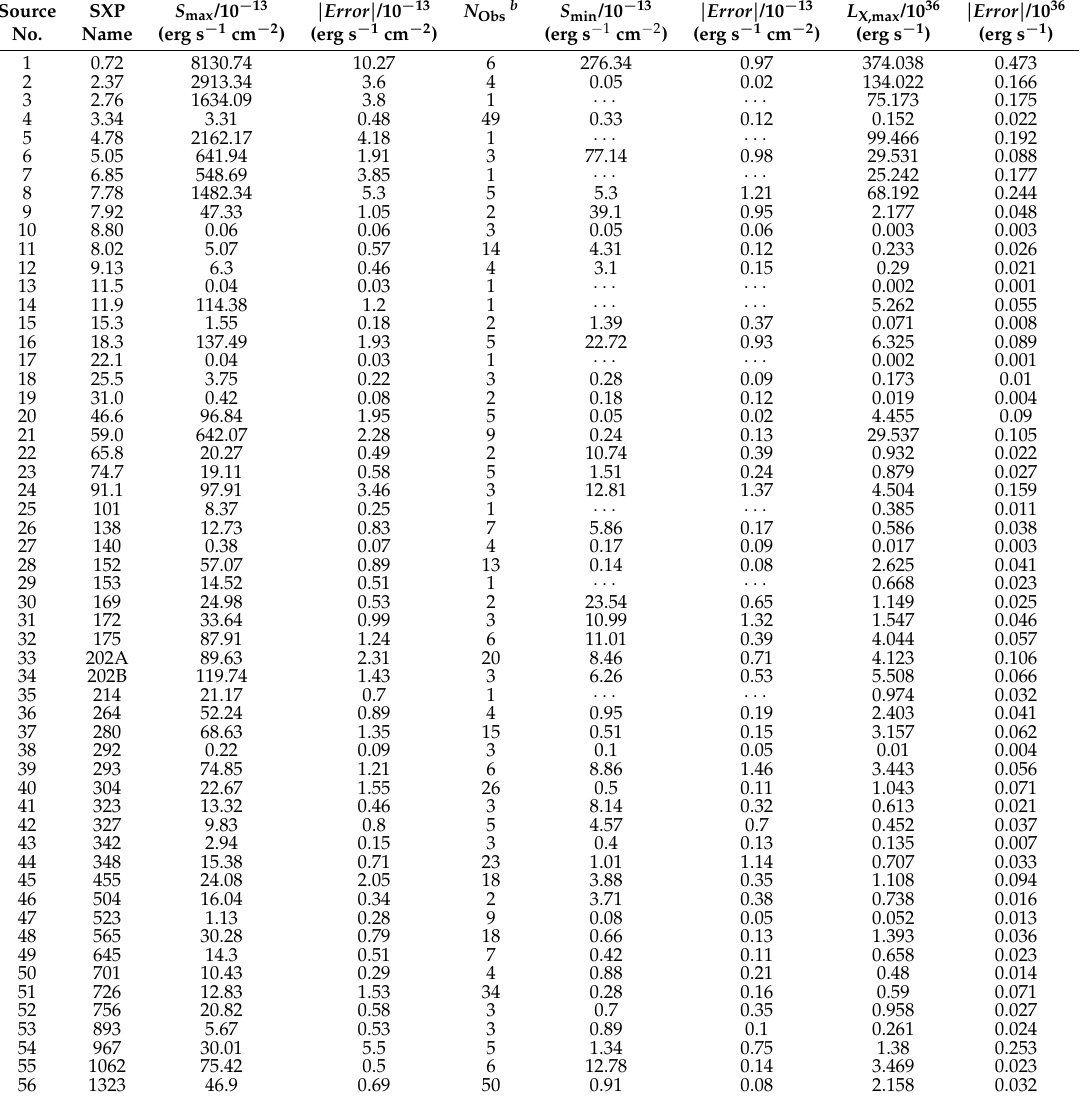
Table 2. SMC SXP fluxes (0.2–12 keV) observed by XMM-Newton (EPIC PN + MOS1 + MOS2) a